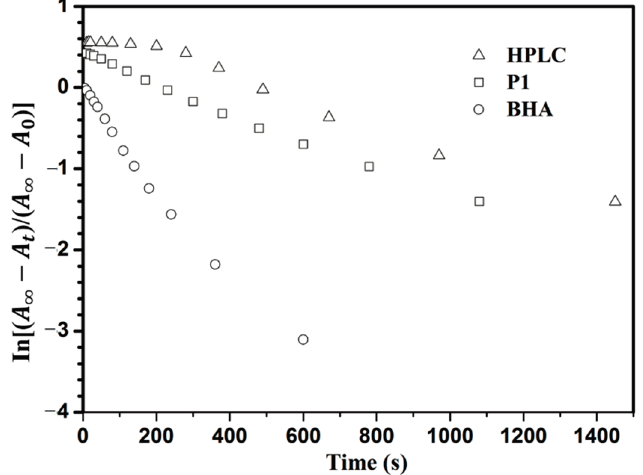
Figure 14. First-order for trans-cis photoisomerization of BHA, the linear poly( ε -caprolactone) (P1, M n GPC = 7400 g/mol, M w / M n = 1.15) and hyperbranched poly( ε -caprolactone) (HPCL, M n GPC = 25,500 g/mol, M w / M n = 2.38). The concentration of the solution is 5.0 × 10 − 5 M during the irradiation time with 365 nm UV light in chloroform solution at room